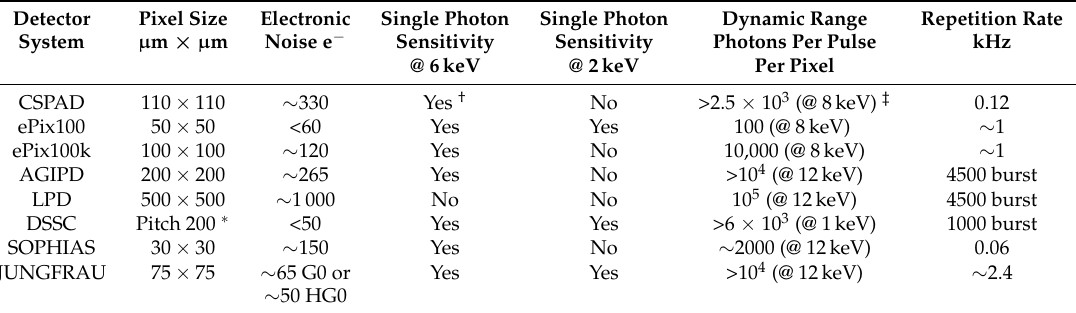
Table 4. Comparison of the main characteristics of the current state-of-the-art pixel detection systems for XFEL hard X-ray light sources. The design characteristics which would limit the applicability of the detection system to SwissFEL are highlighted in